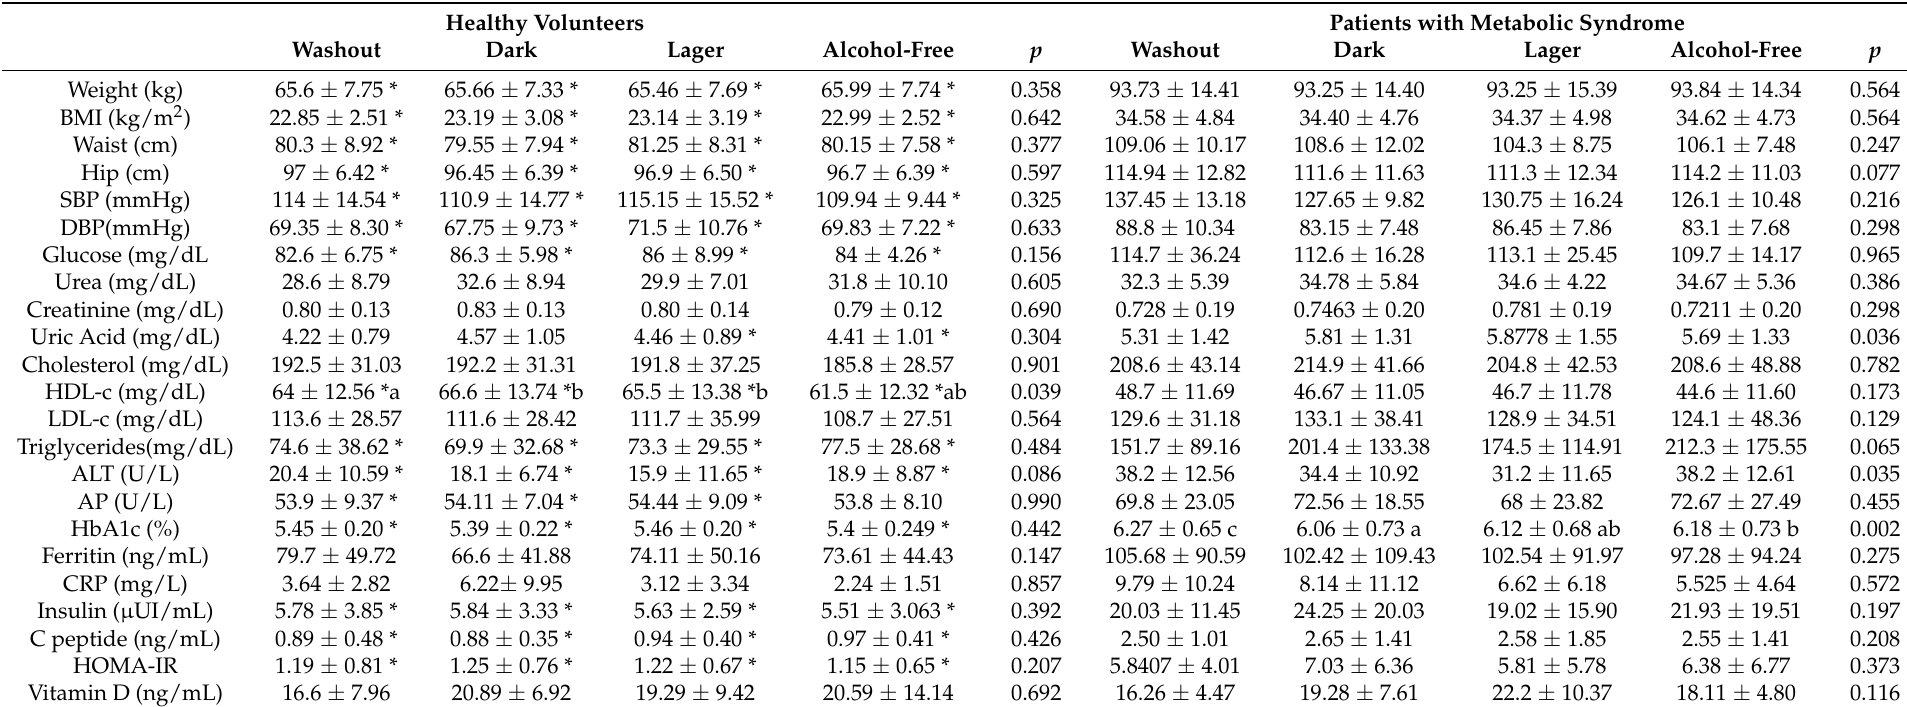
Table 1. Clinical, anthropometric and biochemical characteristics of healthy volunteers and patients with metabolic